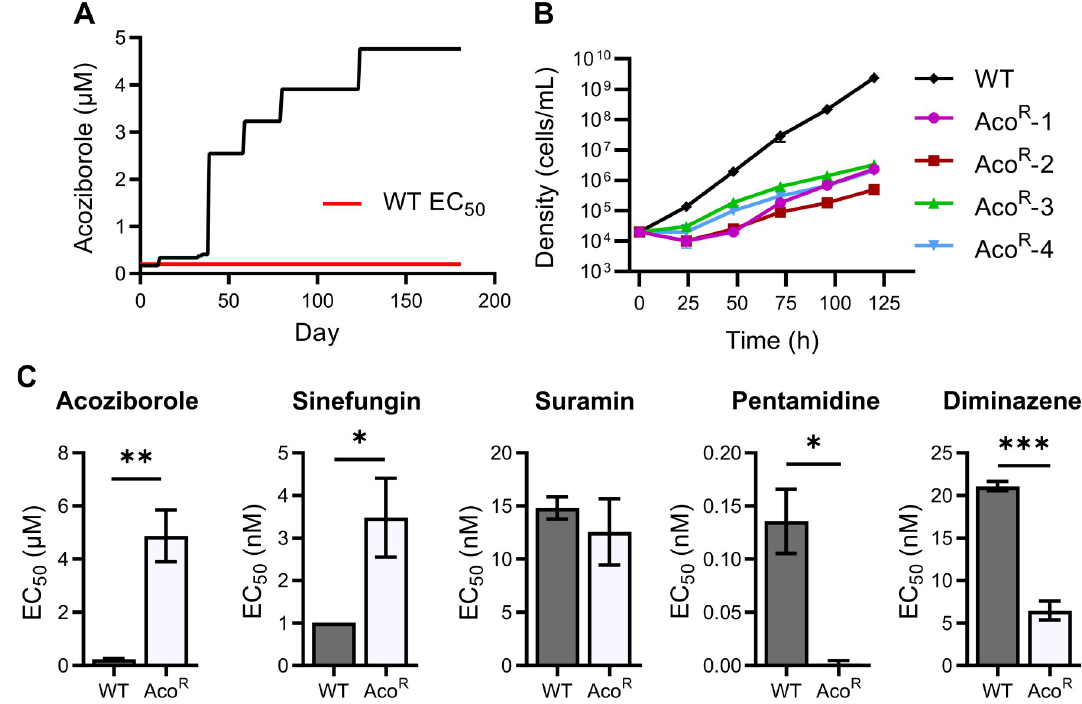
Fig 1. Generation of an acoziborole-resistant cell line and analysis of cross-resistance. A) Acoziborole resistance was generated in T . brucei Lister 427 cells through the addition of incremental concentrations of the benzoxaborole to cell cultures in vitro . Red line indicates mean wild-type EC 50 for acoziborole. B) Cell density of the four Aco R clones, as well as a wild-type control, were monitored daily. Aco R cells were grown in the presence of 4.96 μ M acoziborole and all cell cultures were passaged (seeding density of 2 × 10 4 cells/mL) when density reached 2 × 10 6 cells/mL. Cumulative cell density over a period of 5 days (120 hours) is shown (n = 3 per sample group). C) The Aco R line showed a significantly increased EC 50 compared to wild-type cells. Mean EC 50 was 4.88 ± 0.56 μ M, approximately 25-fold higher than WT cells (EC 50 : 0.25 ± 0.01). Interestingly, Aco R cells also showed an increased resistance to the AdoMet-dependent MTase inhibitor sinefungin, which was shown to act in similar fashion to acoziborole. Aco R cells were hypersensitive to pentamidine and diminazene. All drug sensitivity assays were carried out in duplicate and EC 50 values were obtained from at least 3 independent experiments.